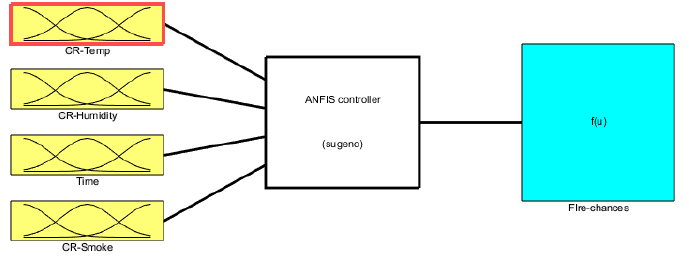
Figure 8. ANFIS Sugeno engine.